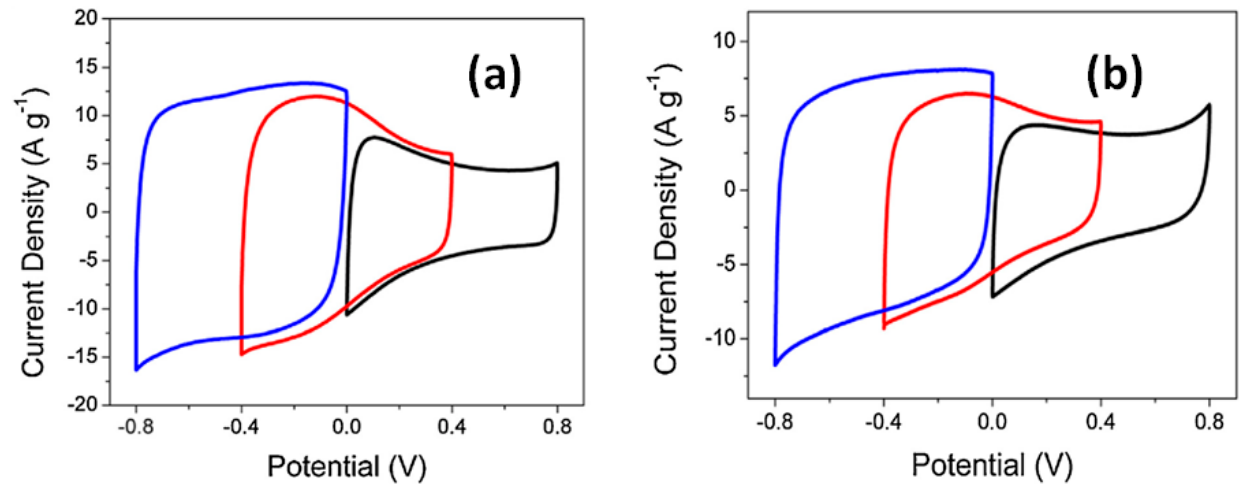
Figure 11. CV curves of rGO-CNT electrode with ratio 10:1 (designated as GC01) obtained in different potential windows at 50 mV/s in Na 2 SO 4 electrolyte ( a ) and NaCl electrolyte ( b ) (Reproduced with permission of [10]. Copyright Elsevier, 2015).